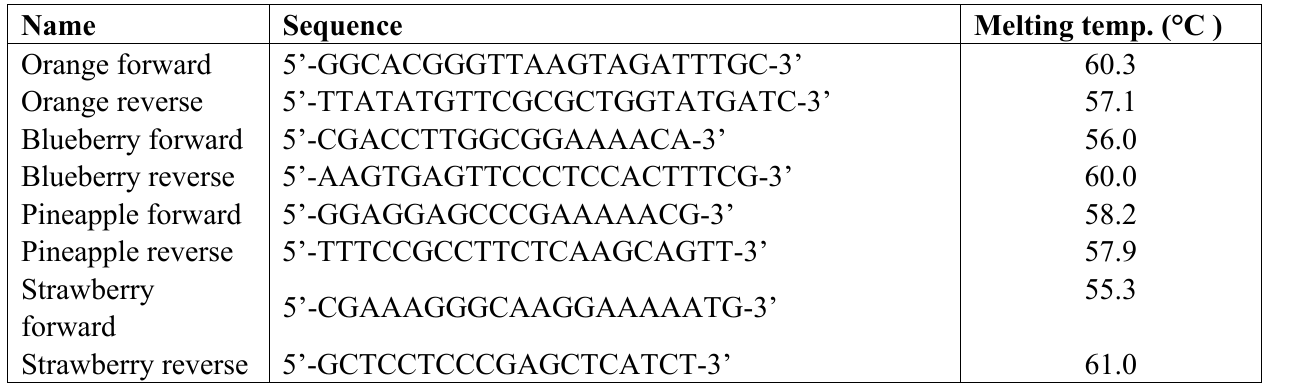
Table 3. Sequences and melting temperatures of primers designed on new